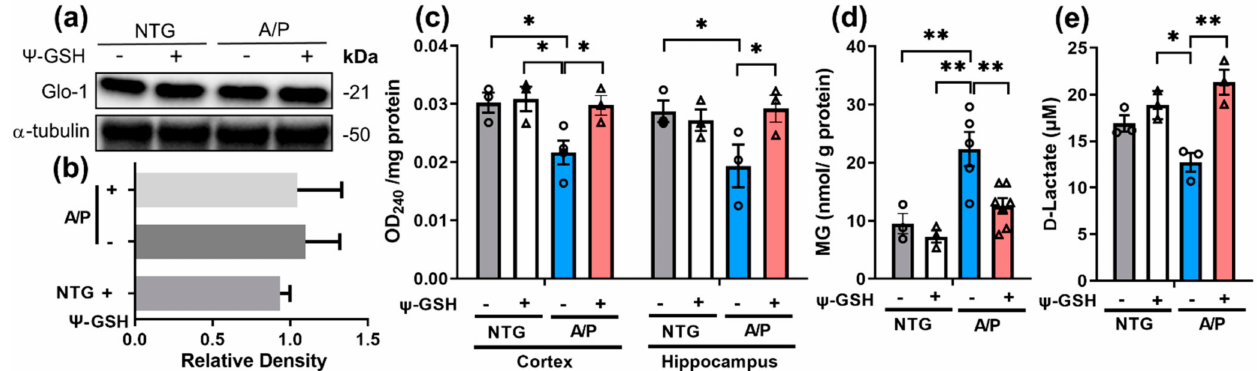
Figure 1. Restoration of Glo-1 enzyme activity after ψ -GSH treatment in symptomatic 14-mo-old APP/PS1 mice. Western blot analysis of the prefrontal cortex brain tissue of NTG and APP/PS1 (A/P) mice treated with saline (-) or ψ -GSH (+) for: ( a ) expression of Glo-1 protein and ( b ) quantification of Western blot in ( a ). ( c ) Endogenous Glo-1 activity was reduced in the cortex and the hippocampus of the vehicle-treated APP/PS1 mice compared to NTG controls. ψ -GSH treatment resuscitated Glo-1 function. ( d ) Increased MG levels in APP/PS1 mice and reduction in MG levels in ψ -GSH-treated APP/PS1 mice. ( e ) Levels of the product of the Glo-1 enzymatic reaction, D -lactate, were increased in the APP/PS1- ψ -GSH group compared to the saline controls, confirming in vivo enhancement of the Glo-1 pathway by ψ -GSH. Data are presented as the mean ± S.E.M. NTG, Saline- and ψ -GSH-treated APP/PS1 groups were compared with a one-way ANOVA with Tukey’s post-hoc test for statistical analysis. * p < 0.05, ** p <